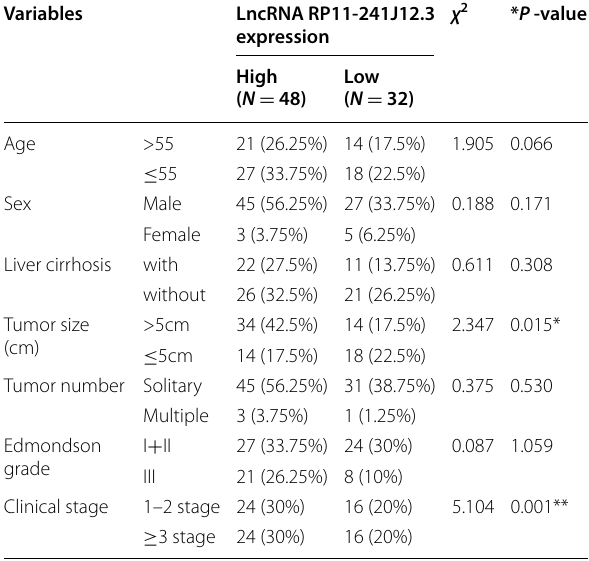
Table 2 Correlation between lncRNA 241J12.3 expression and clinical features of HCC patients ( N =